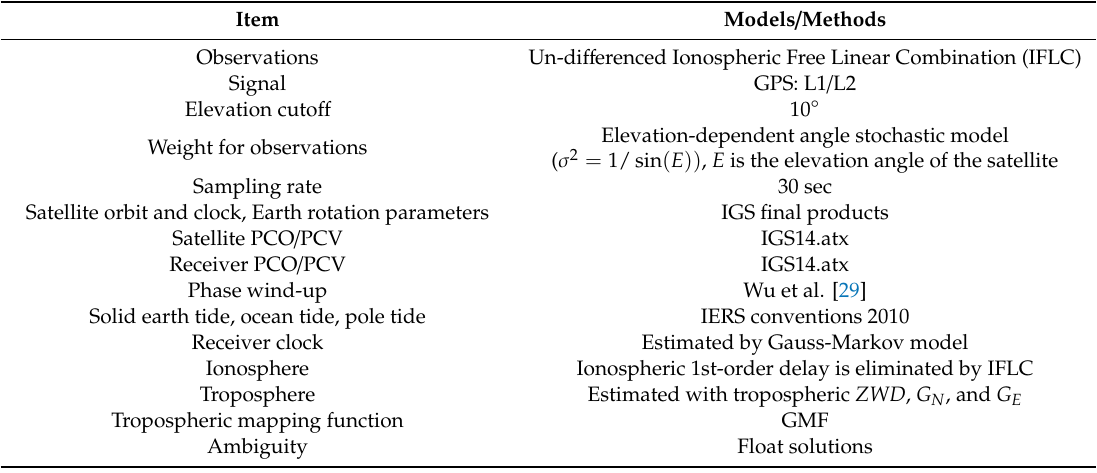
Table 1. Models and methods for the GNSS kinematic precise point positioning